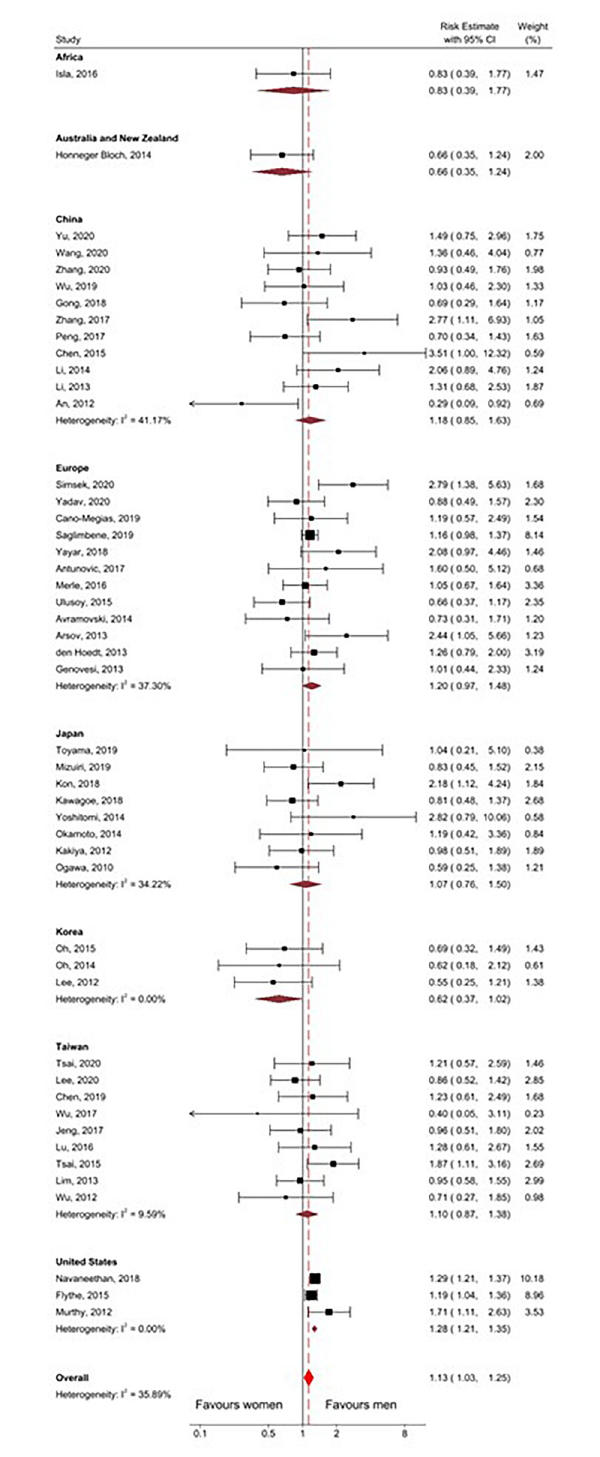
Fig 5. Forest plot of subgroup analysis by country of risk estimates of all included studies. CI, confidence interval. I 2 , Measure of heterogeneity.